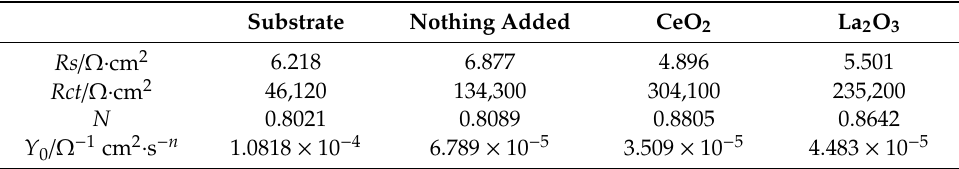
Table 3. Fitting parameters calculated by the equivalent